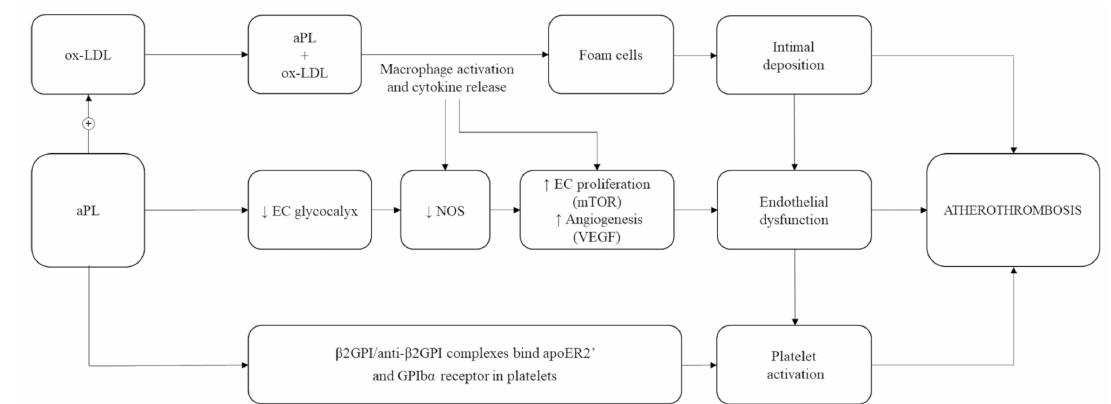
Figure 2. Pathophysiology of atherosclerosis in antiphospholipid antibodies (aPL) carriers. ox-LDL: oxidized low-density lipoprotein; EC: endothelial cells; NOS: nitric oxide synthases; mTOR: mammalian target of rapamycin; VEGF: vascular endothelial growth factor; β 2GPI: β 2-glycoprotein I; anti- β 2GPI: anti- β 2-glycoprotein I antibodies; apoE2R’: apolipoprotein E2 receptor; GPIb α : glycoprotein Ib alfa; ↑ : increased; ↓ : decreased; +: